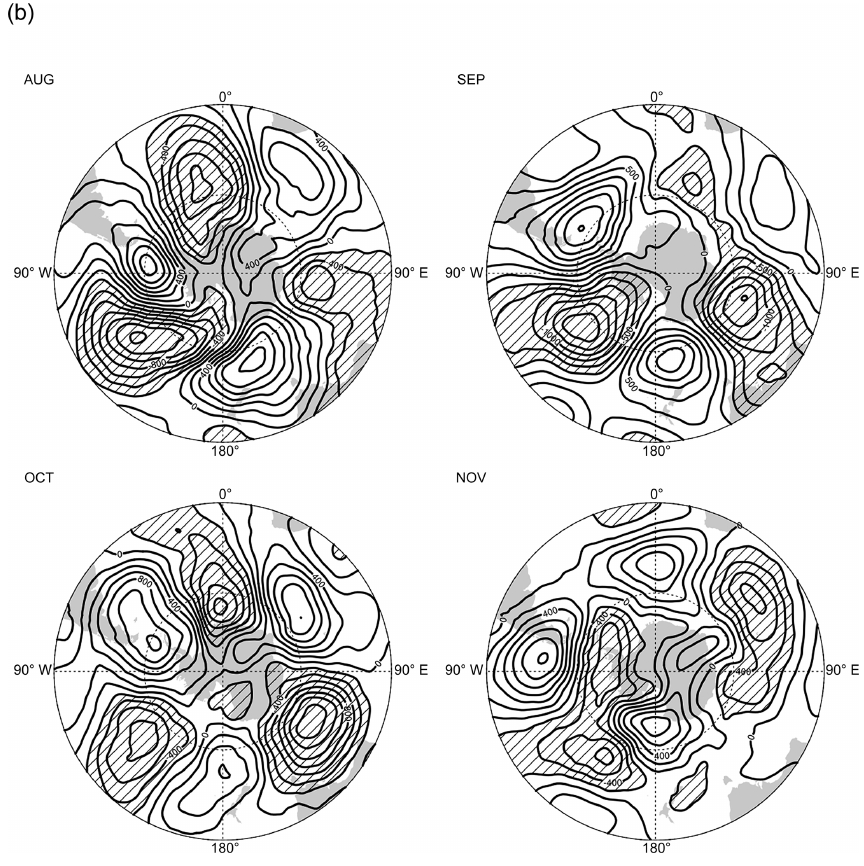
Figure 7. (a) Daily ZW3 index 2013–2016 (see Sect. 2.3 for details). (b) Monthly 500hPa geopotential height zonal mean anomalies from ERA-Interim (Dee et al., 2011) for the period August–November 2016. Hatched areas indicate strongly negative values.